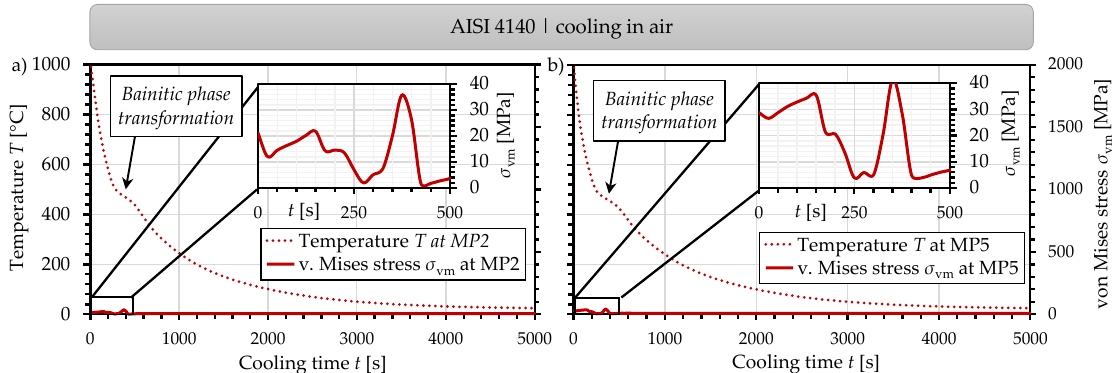
Figure 11. Temporal development of the temperature and von Mises stress at MP2 ( a ) and MP5 ( b ) during the cooling of AISI 4140 in air.